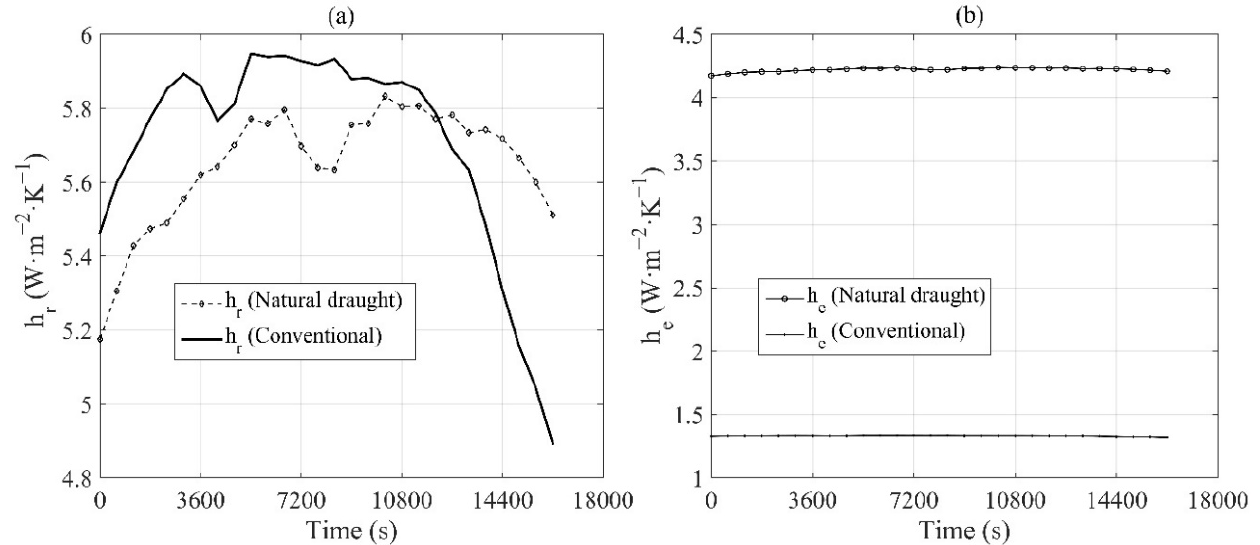
Figure 5. Radiative and effective heat transfer coefficient between the absorber and air stream: ( a ) radiative heat transfer coefficient ( h r ), ( b ) effective heat transfer coefficient ( h e ).